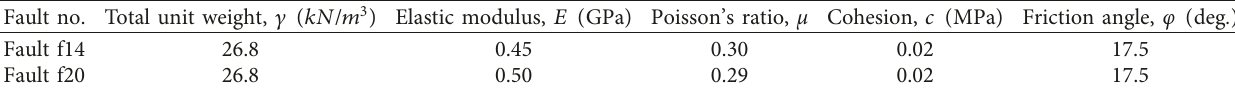
Table 2: Mechanical properties of the two